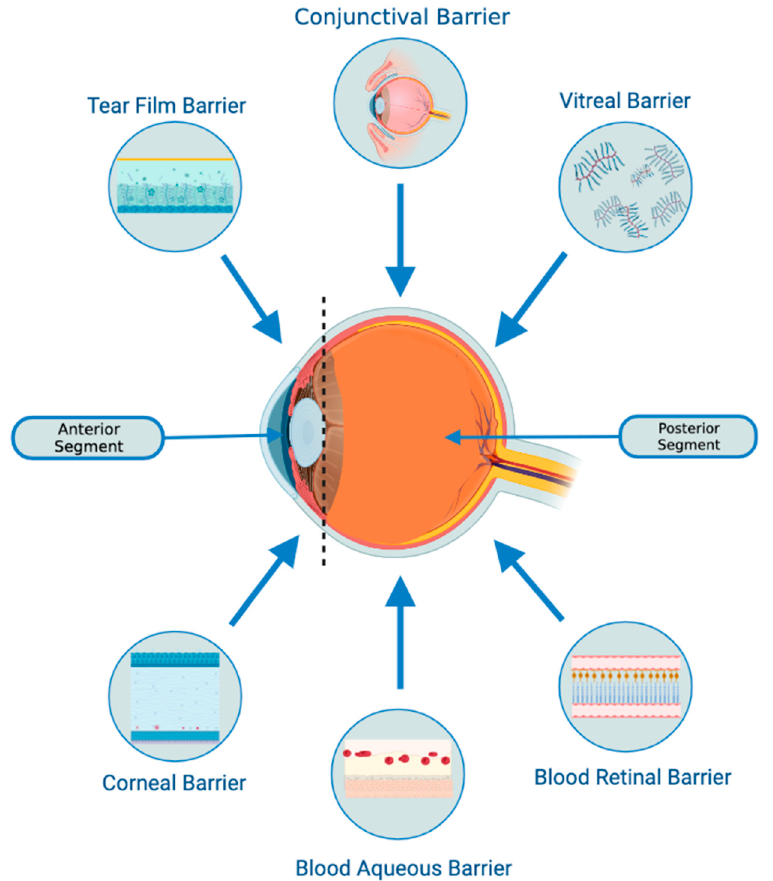
Figure 1. Biological barriers of the eye. The tear film barrier comprises three layers (lipid, aqueous, and mucin) and is continuously removed from the eye surface by lacrimal fluid secretion, resulting in rapid drug removal. The corneal barrier serves as a mechanical and chemical barrier, limiting the access of exogenous substances into the eye. Tight junctions on the corneal epithelium surface prevent the diffusion of macromolecular and hydrophilic molecules. Intravitreal administration offers a direct path to the vitreous and retina but may impede the diffusion of larger, positively charged drugs across the retinal pigment epithelium (RPE) barrier to the choroid. The blood-ocular barrier (BOB) poses a significant challenge to systemic and topical drug delivery in the anterior and posterior chambers of the eye. It comprises the blood-aqueous barrier (BAB) and the blood-retinal barrier (BRB). The BAB, associated with the anterior chamber, consists of endothelial cells, iris, ciliary muscle, and pigmented and non-pigmented epithelium cells with tight junctions that restrict drug molecule